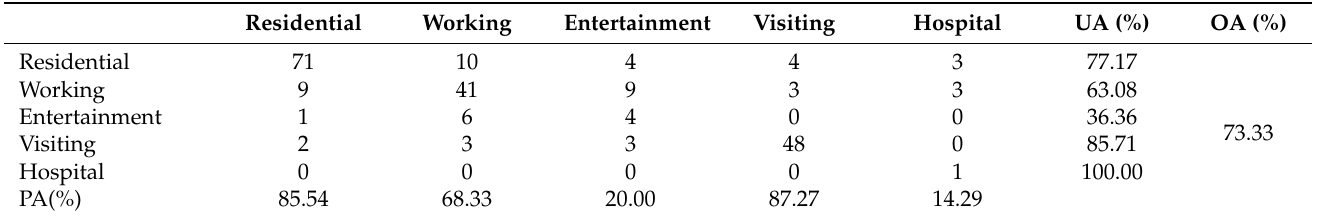
Table 8. The confusion matrix of the S2-RF model-predicted BFTs for the 10 independent experiments with the prediction accuracy ranked 5th.